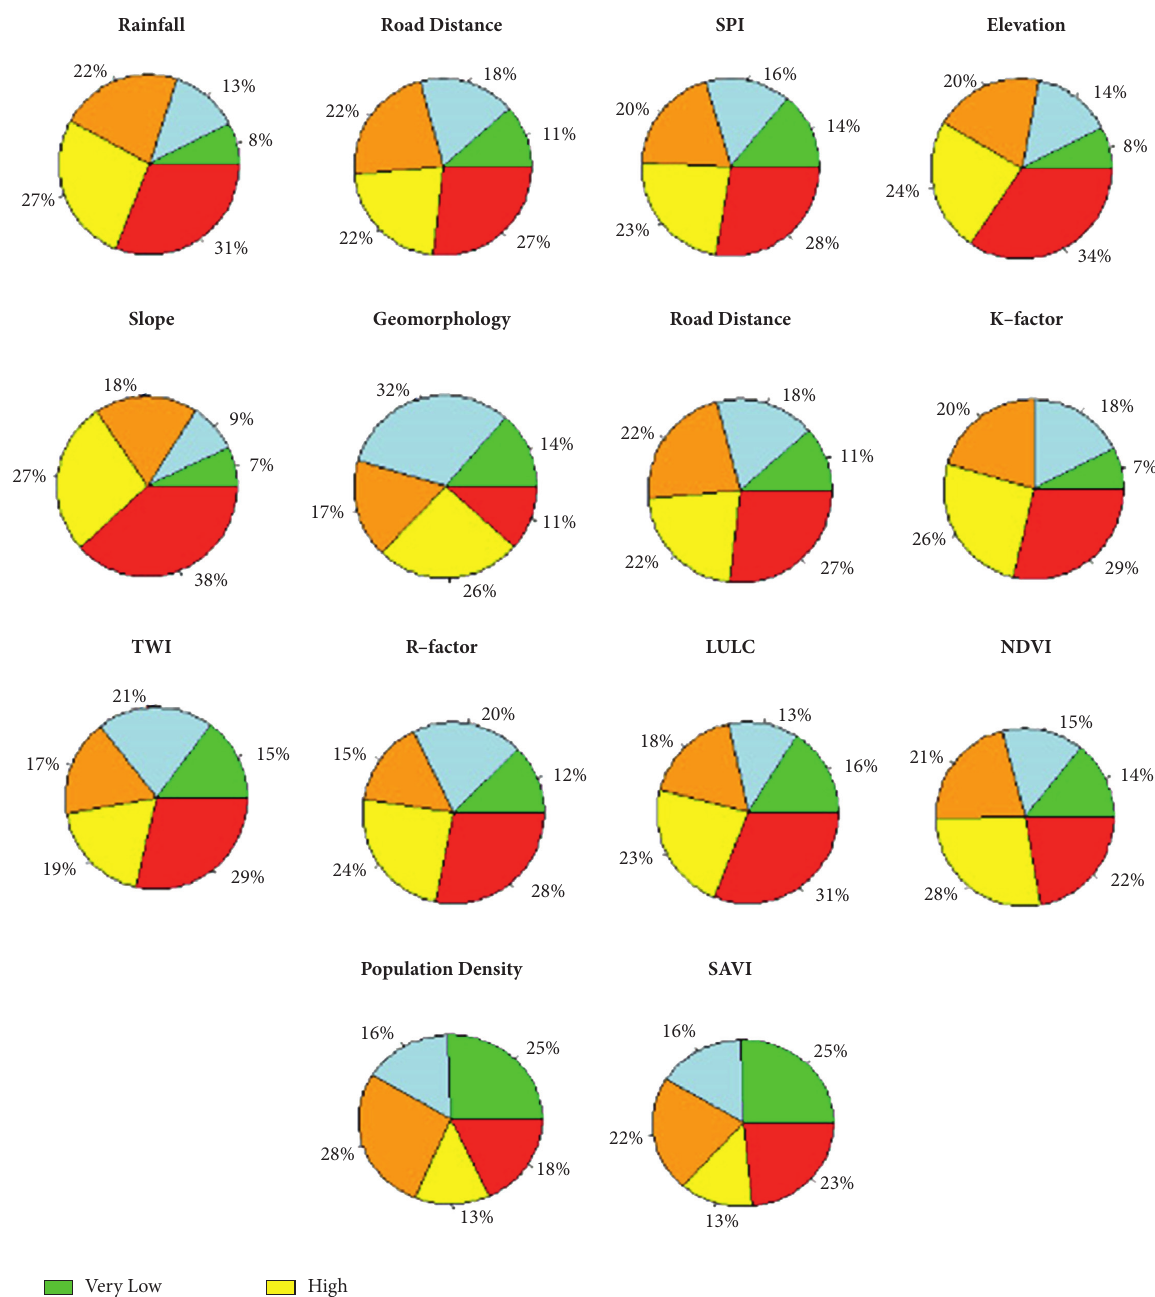
Figure 10: The percentage of importance of flood causing